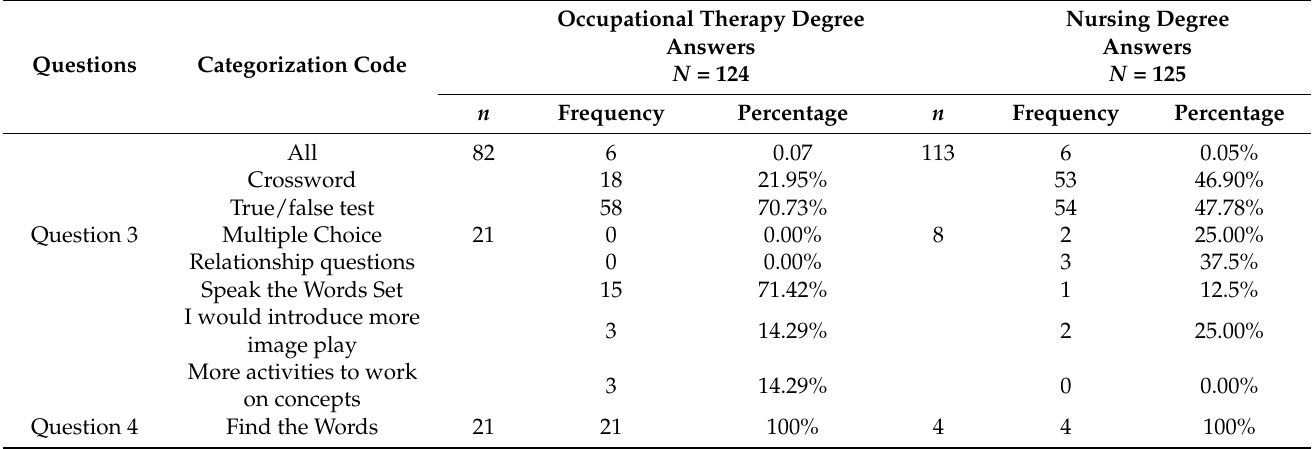
Table 6. Frequencies and percentages in the categorized open-ended responses in bachelor’s degree students of occupational therapy and nursing.